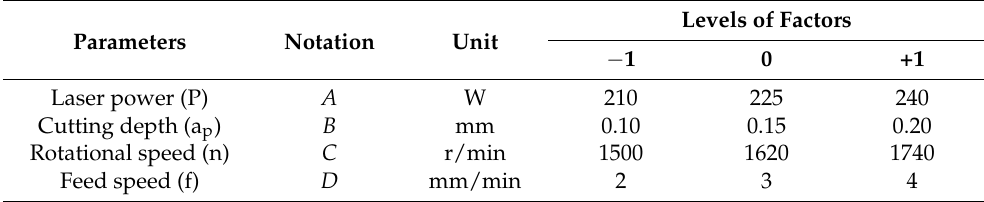
Table 3. Response surface experimental factor levels.